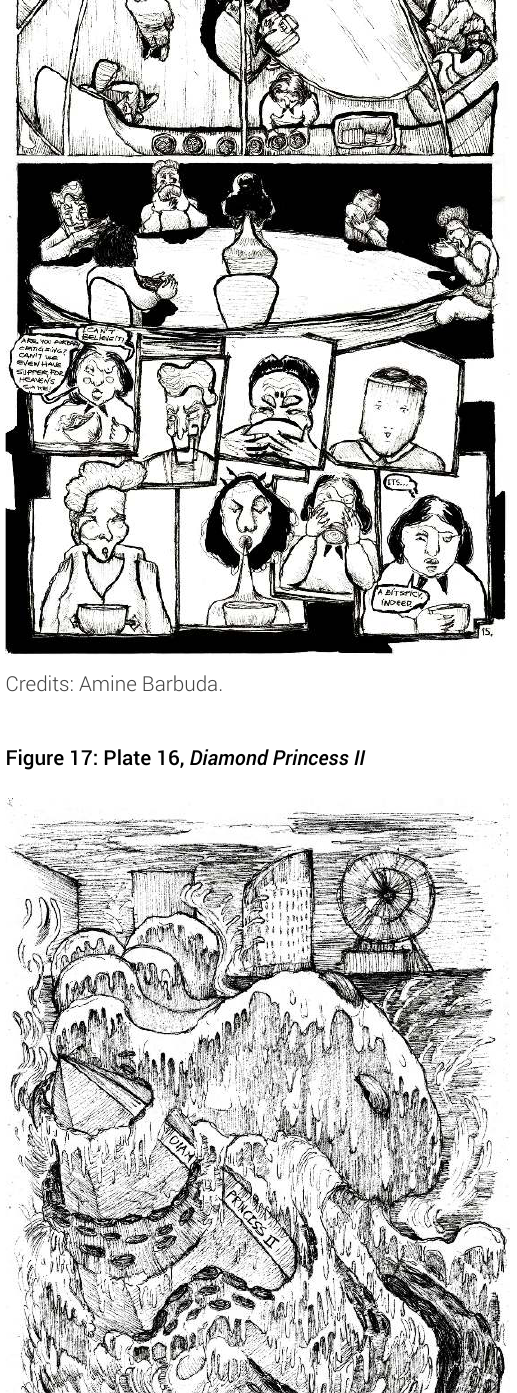
Figure 16: Plate 15, Diamond Princess II